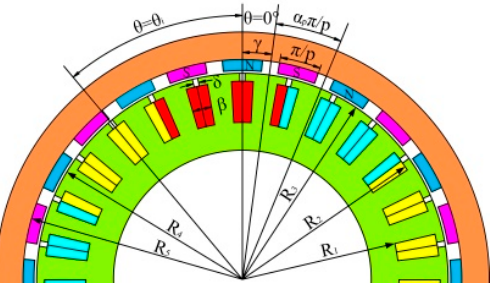
Figure 1. Configuration of the the direct drive permanent magnet motor (DDPMSM).